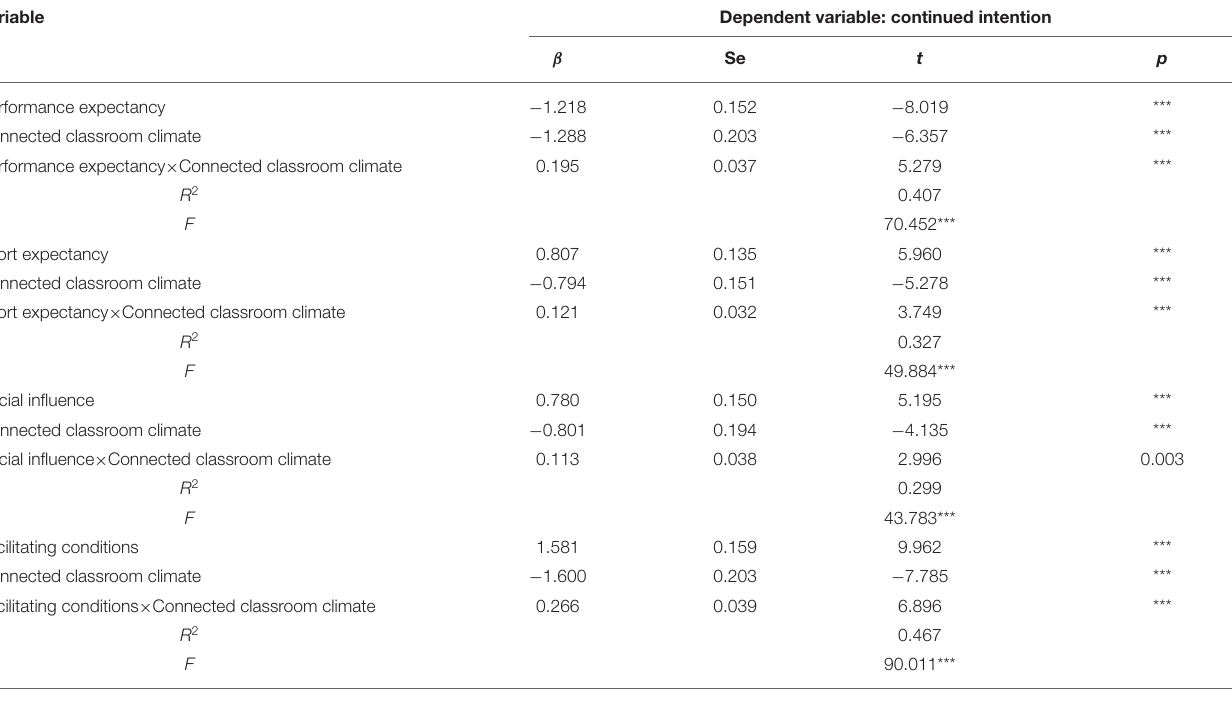
TABLE 7 | Moderation effect of CCC between UTAUT and CI.